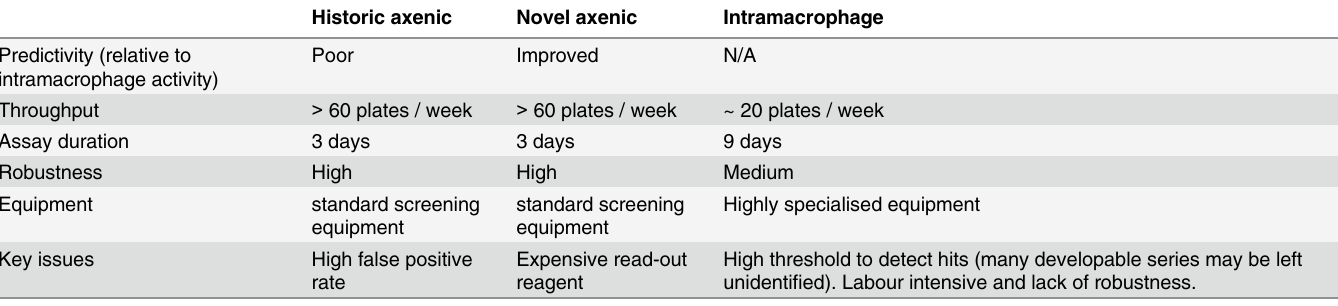
Table 2. Suitability of the Leishmania donovani assays for diversity